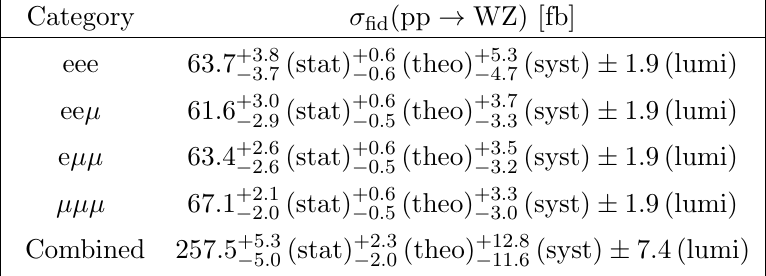
Table 5 . Measured (cid:12)ducial cross sections and their corresponding uncertainties for each of the individual (cid:13)avour categories, as well as for the combination of the four. The combined value is the result of a simultaneous (cid:12)t to the four categories, therefore both the central value and its total uncertainty di(cid:11)er from the sum of the central values and the quadratic sum of the uncertainties respectively, because of correlations among sources of uncertainty in the categorized values.